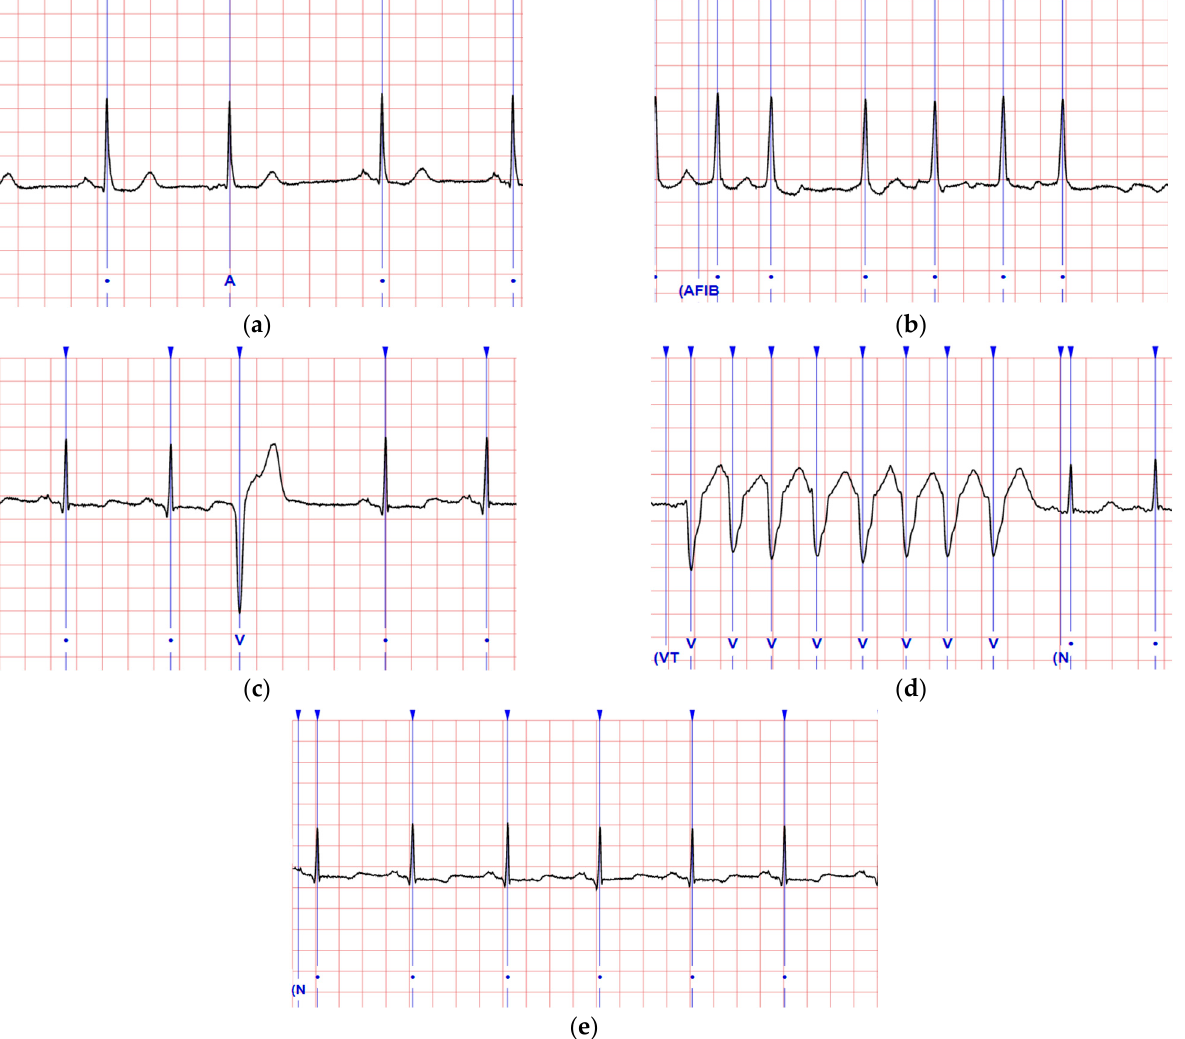
Figure 2. Typical ECG waveforms of the arrhythmia symptoms with annotation by screenshots from MIT-BIH’s web site [18]: ( a ) atrial premature complex (APC); ( b ) atrial fibrillation (AFib); ( c ) ventricular premature complex (VPC); ( d ) ventricular tachycardia (VT); ( e ) normal sinus rhythm